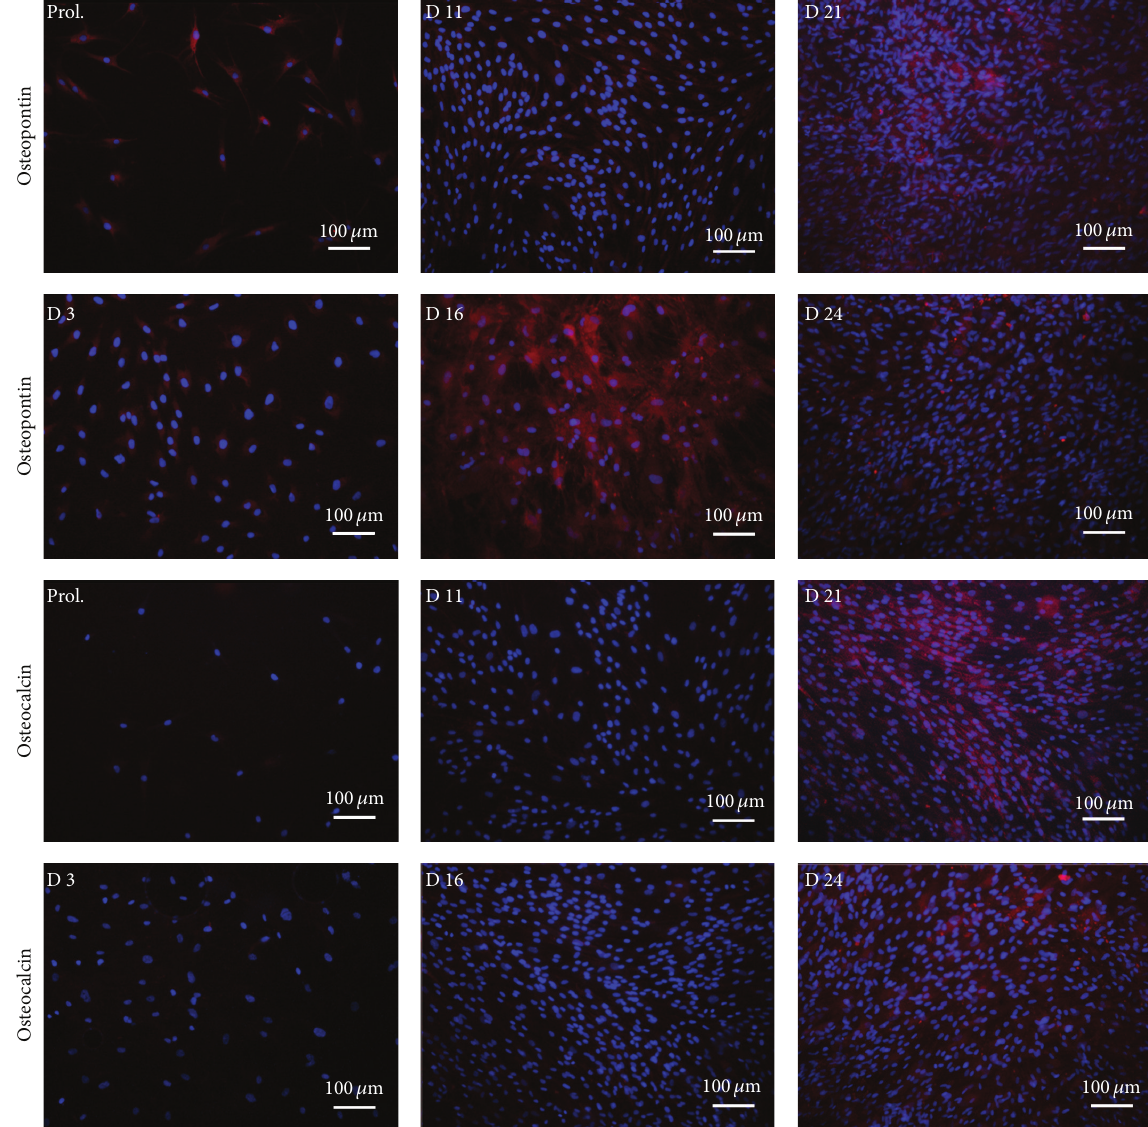
Figure 4: Early and late markers during osteogenic differentiation. Immunocytochemical analysis of OP and OC at specific time points (proliferation, days 3, 11, 16, 21, and